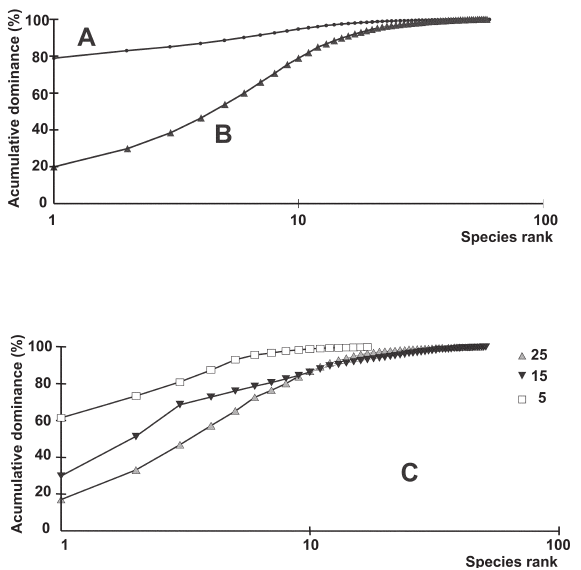
Fig . 4. – Analysis of accumulative abundance. A: of total species, B: without Diogenes pugilator , C: without Diogenes pugilator ac- cording to depth.